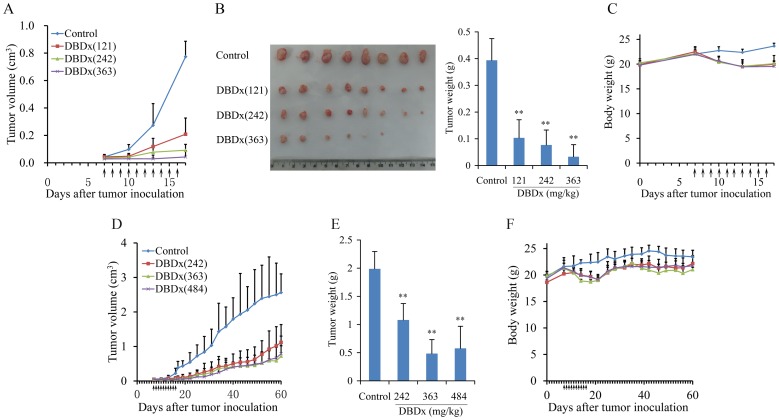
DBDx inhibited the growth of BEL-7402 xenograft in athymic mice.
A. DBDx inhibited tumor growth in a dose-dependent manner. B. At day 17, mice were sacrificed. Tumors were photographed and tumor weights were measured. C. The body weights of mice during the 17 days' experiment. D. In the long term experiment, at day 60, namely 44 days after the final treatment, DBDx could still inhibit the tumor growth. E. At the end of the experiments, mice were sacrificed and tumor weights were measured. F. The animal body weights of all groups during the 60 day experiment. (Dose: mg/kg). Statistical significance was determined by Student's t-test; **P<0.01 compared with control.